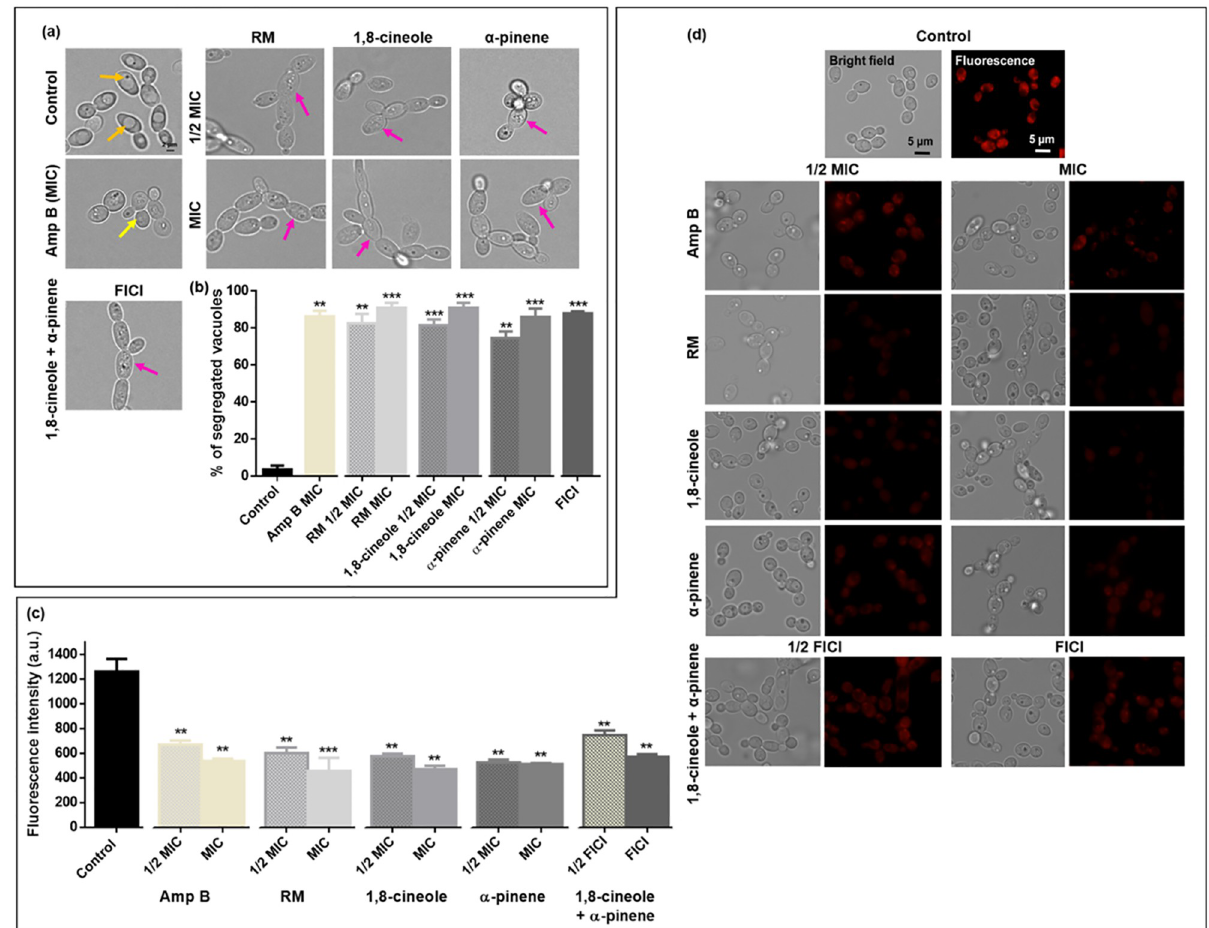
Fig 4. Impact of RM oil and its components on C . albicans organelles. (a) RM oil, 1,8-cineole, and α -pinene at MIC, and the two components at FICI, induced vacuolar fragmentation (pink arrows) as compared to control (orange arrow). The positive control, Amp B, at MIC showed partial (yellow arrow) segregation compared to EO(C)-treated cells. Scale bar for control is 2 μ m and represents the scale for all images. (b) Bar graphs show significant differences in % segregated vacuoles for control versus treated cells. (c) Bar graphs show C . albicans exposed to EO(C)s have a greater number of damaged mitochondria compared to control. (d) Representative bright field (left) and fluorescence ( right ; λ ex = 644 nm; λ em = 665 nm) images of Candida exposed to RM oil, 1,8-cineole, α -pinene at 1/2 MIC and MIC, and the two components at 1/2 and full FICI showed poor uptake of the Mitotracker deep red as compared to control. Scale bars of control images are 5 μ m and applicable to all images. Data are presented as the mean ± SEM of three biological replicates, with 300 and 100 cells per replicate for vacuole and mitochondria, respectively, for which statistical significance ( ��� , p < 0.001; �� , p < 0.01) was analysed by an unpaired Student’s t